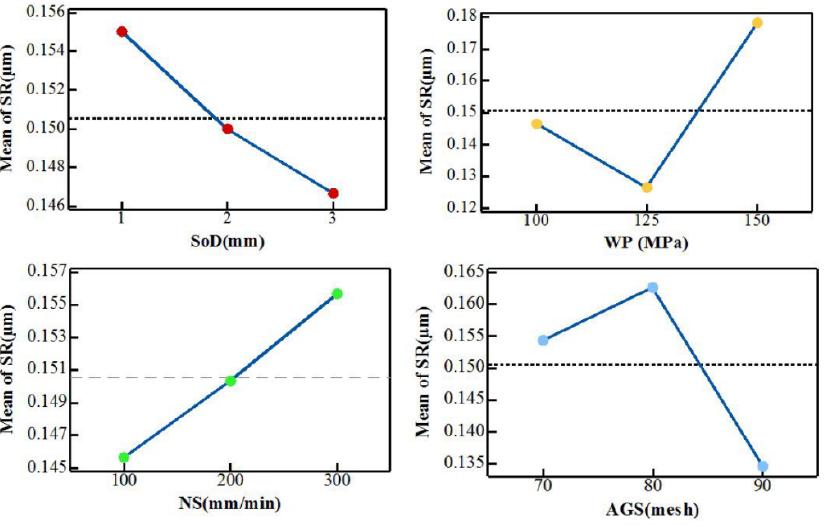
Figure 3. The effects of process parameters on SR [45]. Figure 3. The e ff ects of process parameters on SR [45].